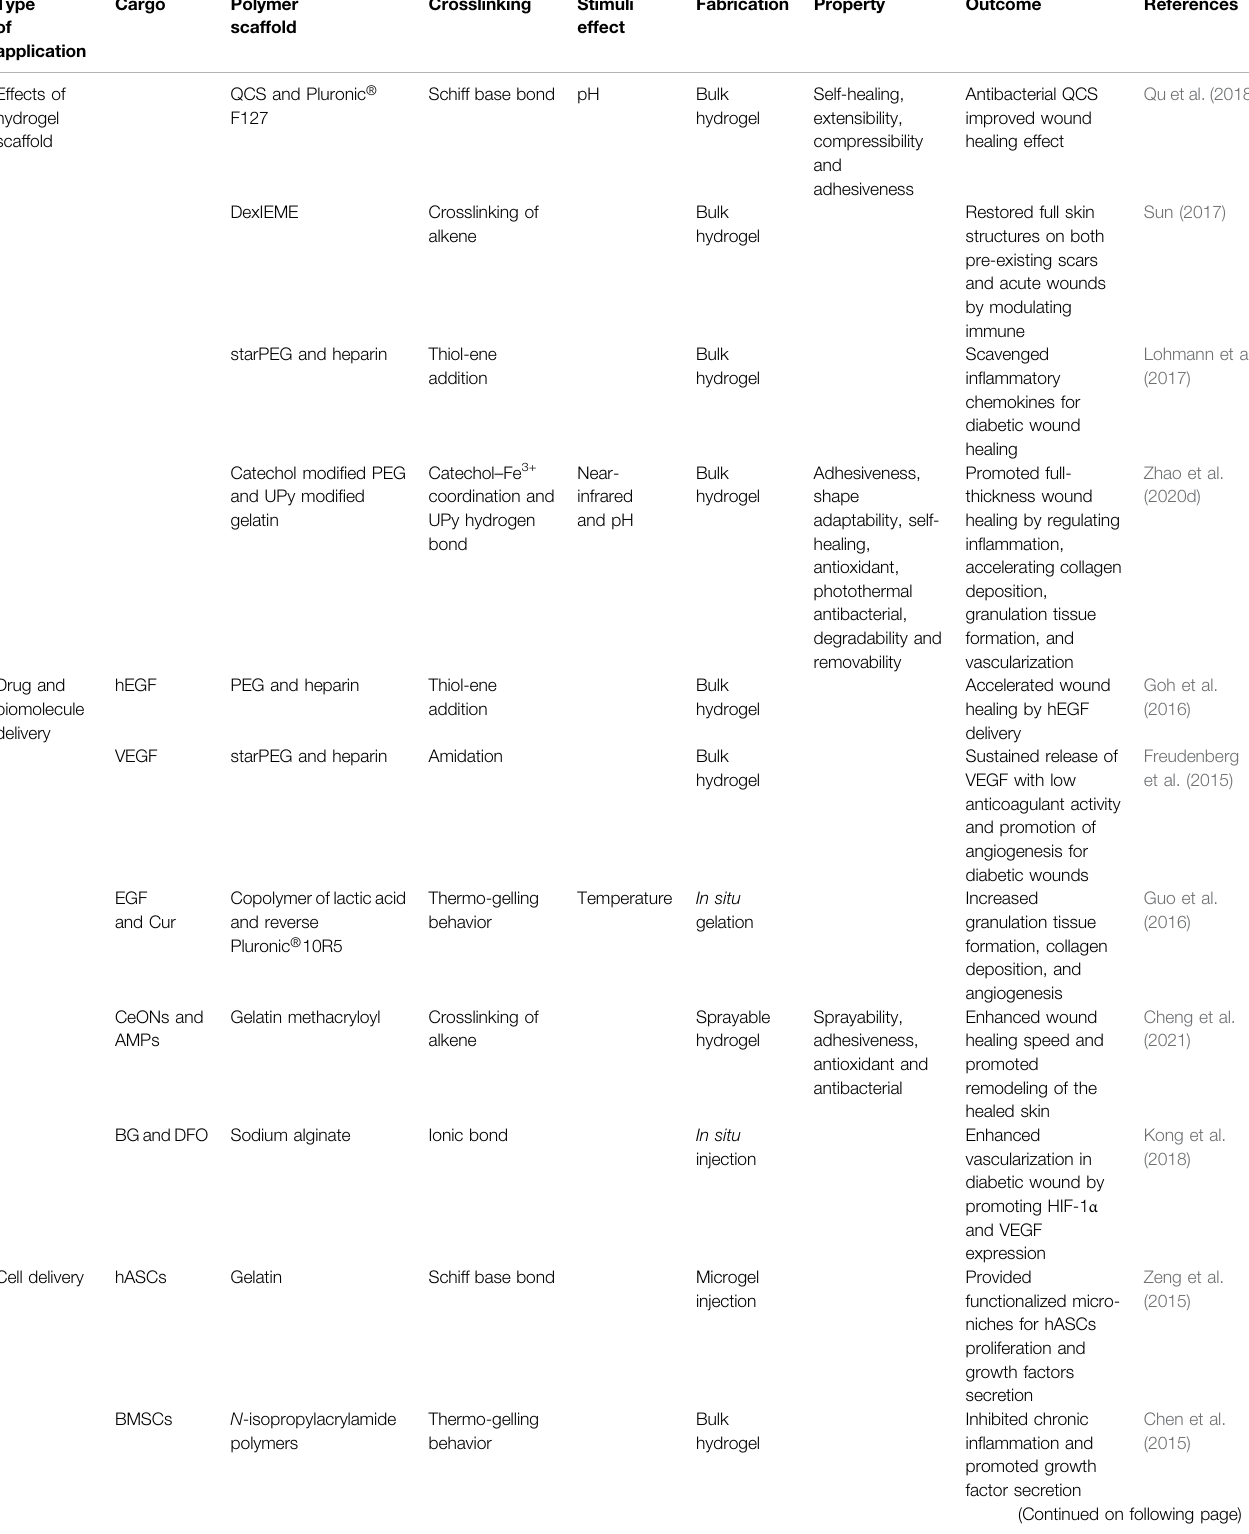
TABLE 1 | The fabrication and application of hydrogels for wound